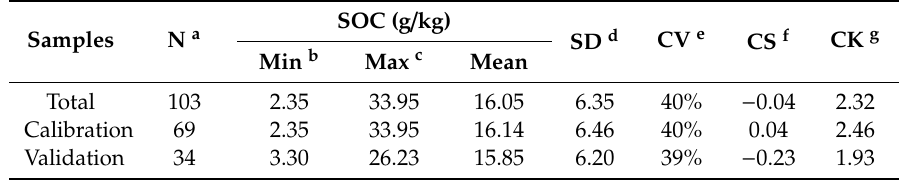
Table 1. Descriptive statistics of soil organic carbon (SOC) of soil samples (Dataset 0).